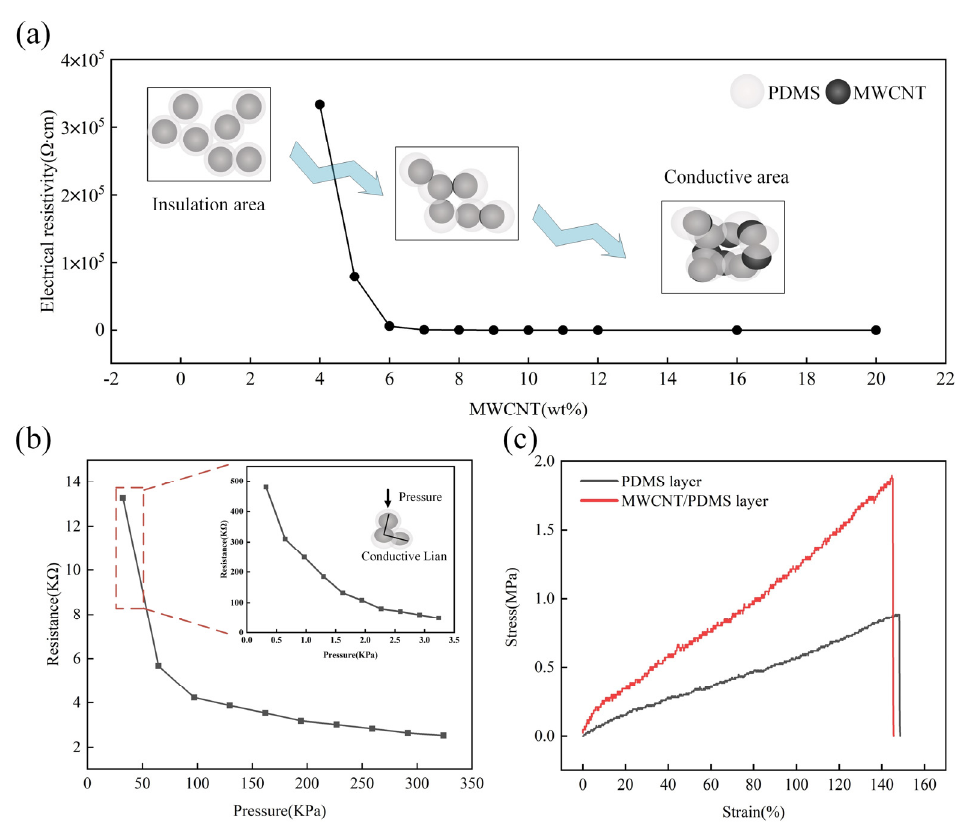
Figure 4. ( a ) Percolation curve of MWCNT/PDMS conductive layer; ( b ) resistance variation of MWCNT/PDMS layer under high-pressure range (0 − 330 KPa) and under low − pressure range (0 − 3.3 KPa); and ( c ) stress-strain curves of pure PDMS layer and MWCNT/PDMS layer.